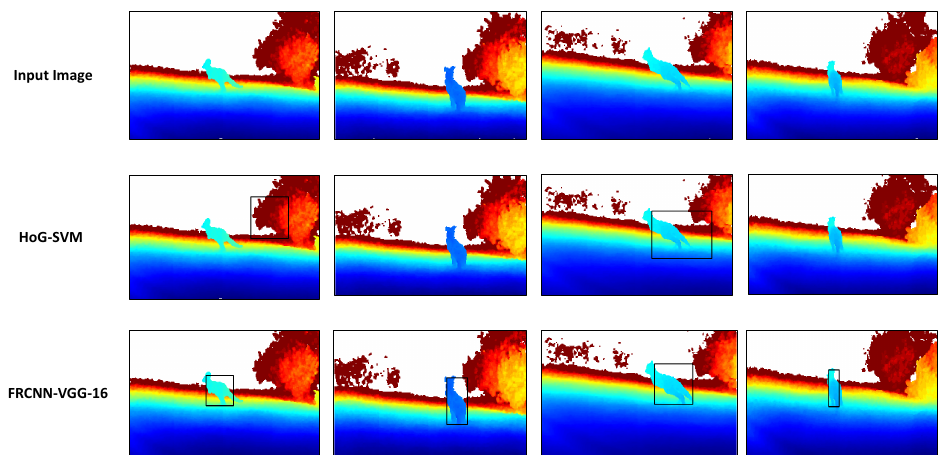
Figure 6. Qualitative results on real live kangaroo dataset. Top : the input colorized real depth images. Middle : Output of the HoG-SVM models. Bottom : output of proposed FRCNN-VGG-16 kangaroo detection